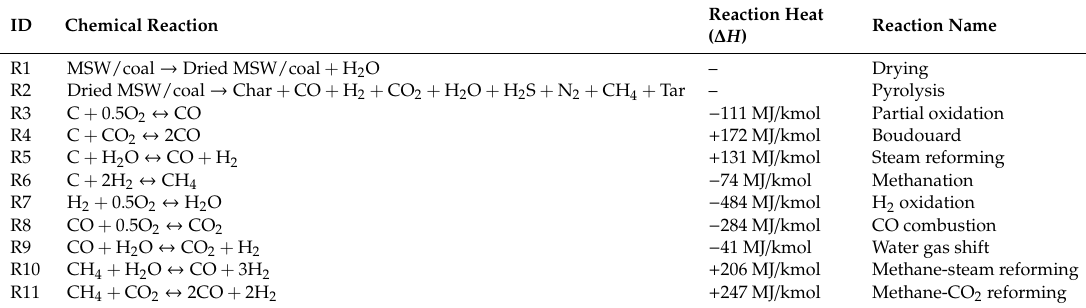
Table 2. Chemical reactions in the co-gasification process of MSW and bituminous coal (BC) [25–28]. ID Chemical